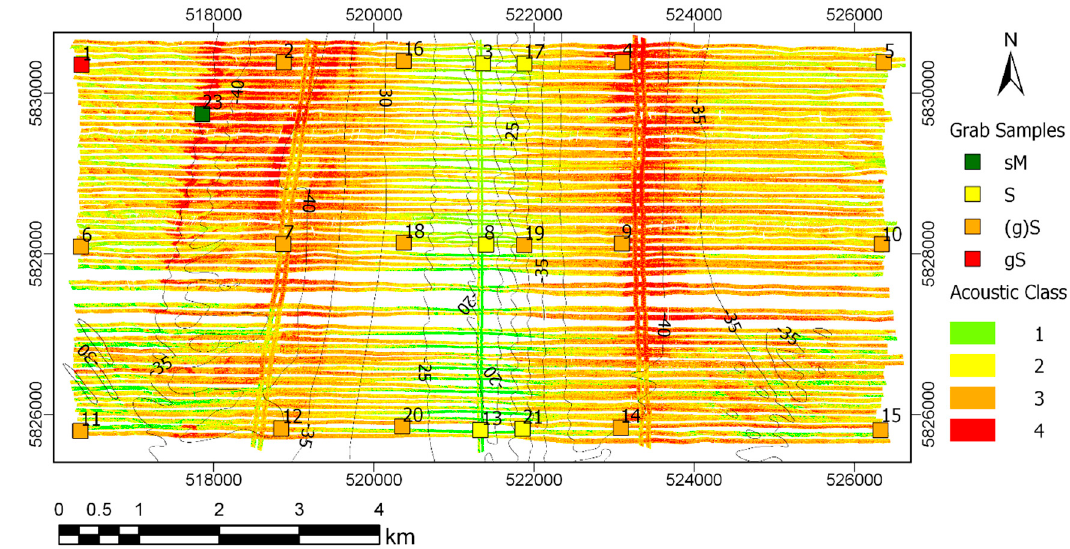
Figure 2. Bayesian classification map along with grab samples based on Folk scheme. Four acoustic classes ranging from lowest backscatters (green) to highest values (red), figure from Koop et al.